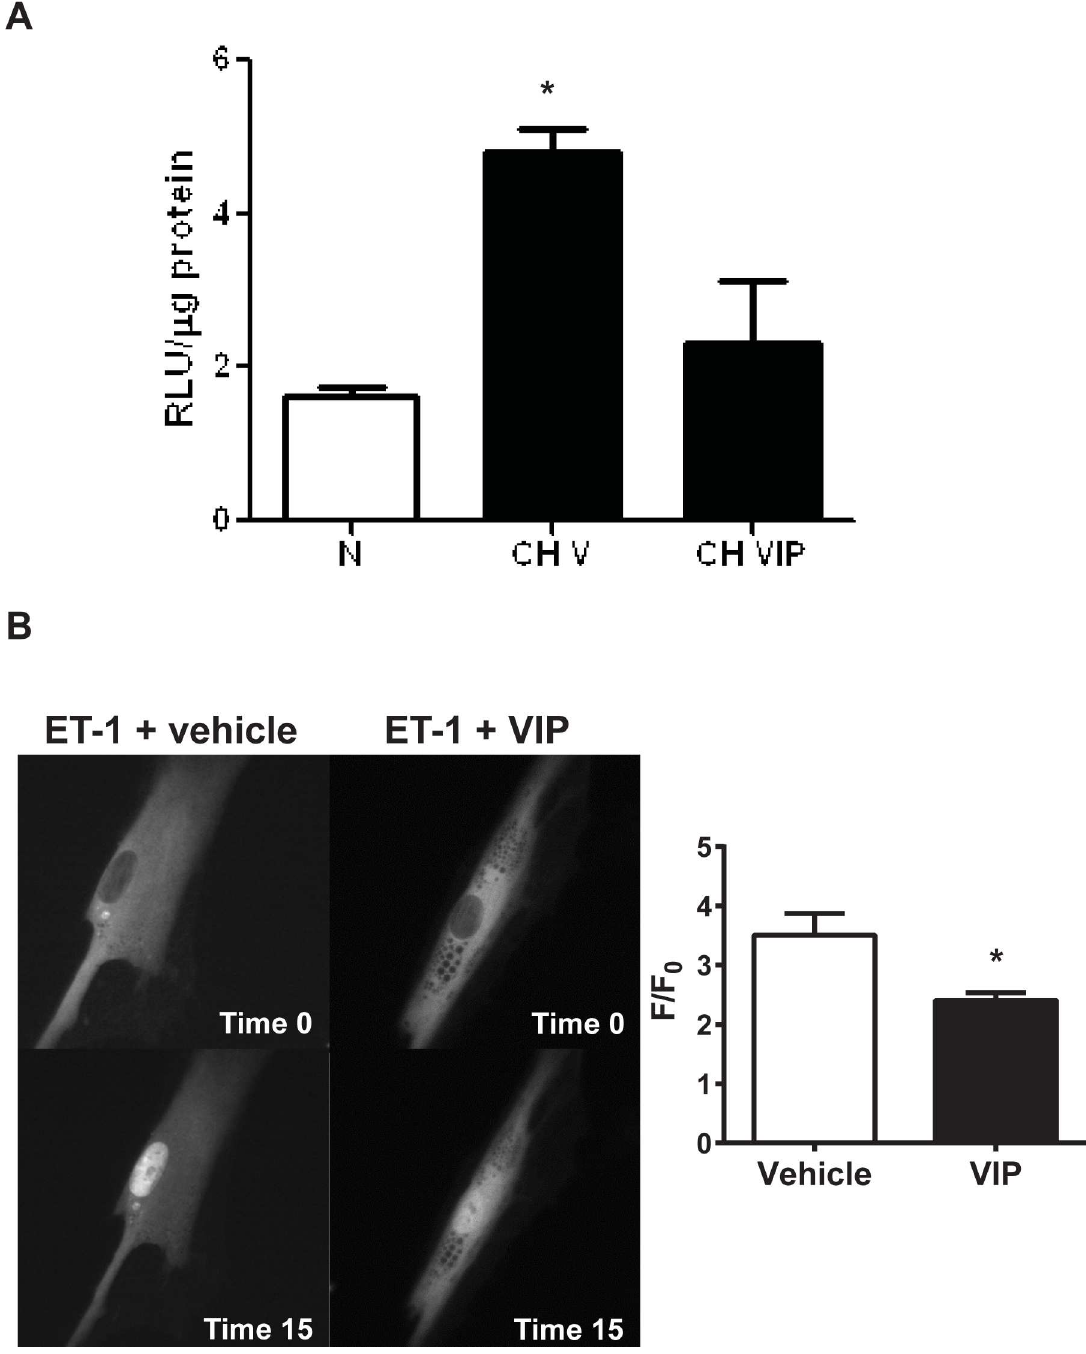
Fig 1. VIP attenuates NFAT activation. A) VIP administration inhibited CH-inducedNFAT activationin isolatedmouse intrapulmonary arteries. RLU = relativeluciferase units. N = normoxia, CH V = 2 days chronichypoxia.CH VIP = VIP (0.166 mg/kg/day) in osmotic pump one day prior and duringCH exposurefor 2 days. * p < 0.05vs N and CH VIP, n = 3–5 mice. ANOVA followedby Newman-Keuls. B) VIP attenuated ET-1-induced NFATc3-EGFP nuclear import in humanPASMC. * p < 0.05,n = 5 cells.